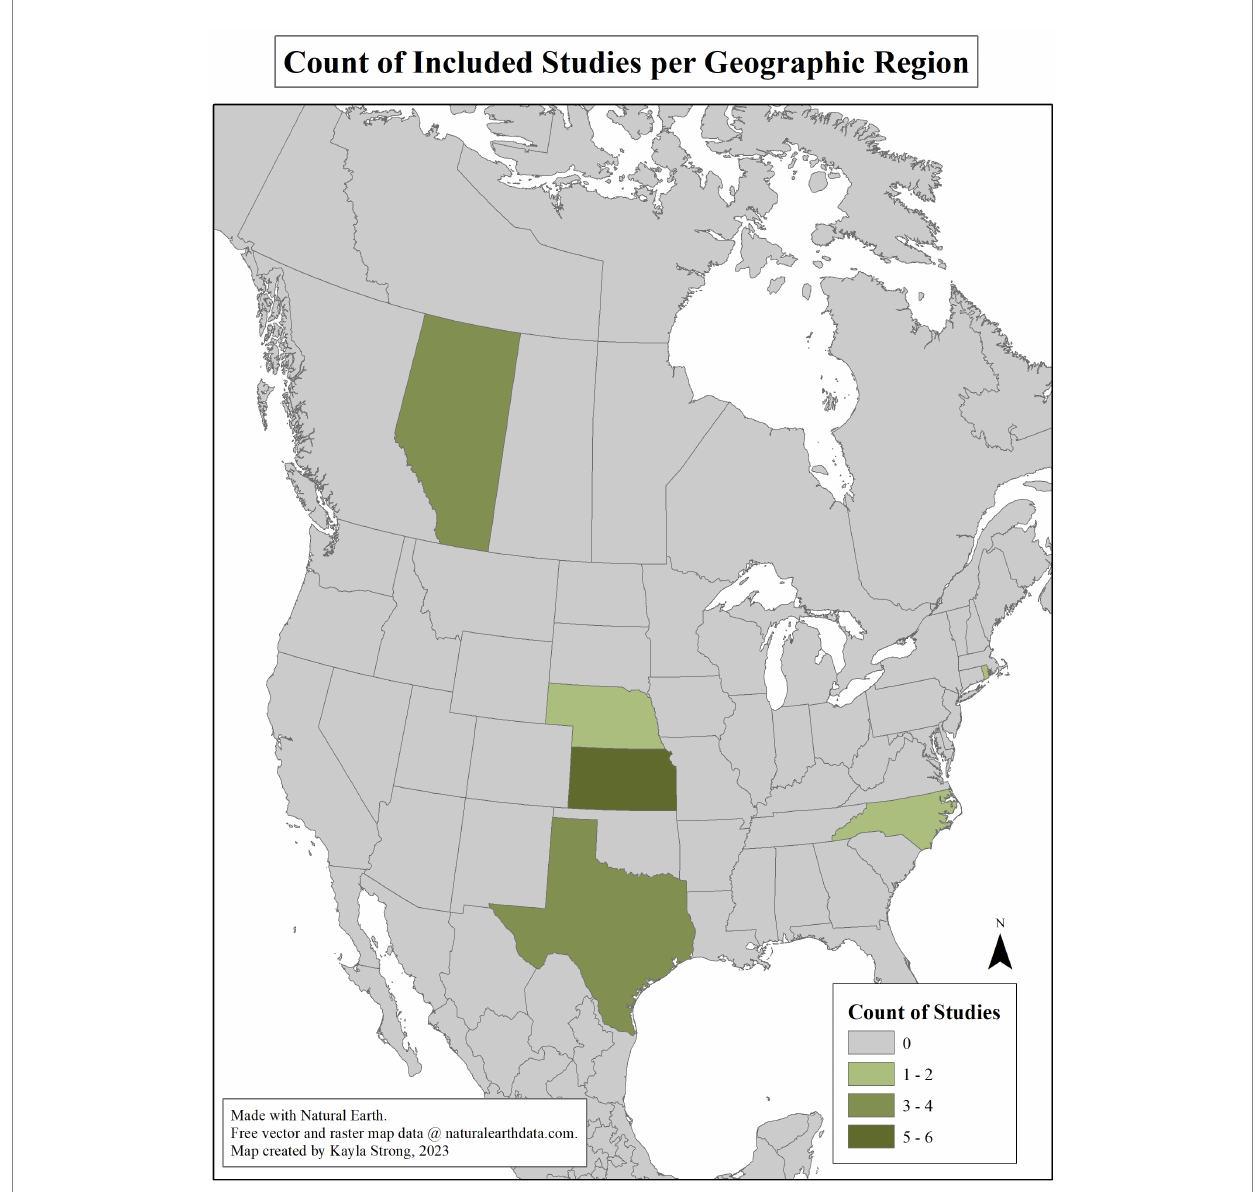
FIGURE 2 Geographic distribution of articles included in the Scoping review of reported factors associated with antimicrobial resistant enterococci in Canadian beef cattle. Seven articles’ research locations in the United States were not state-specific and are thus not included in the